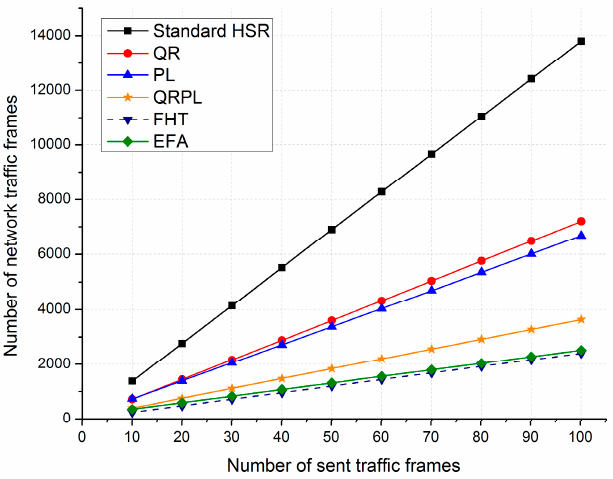
Figure 13. A comparison of network traffic performance.